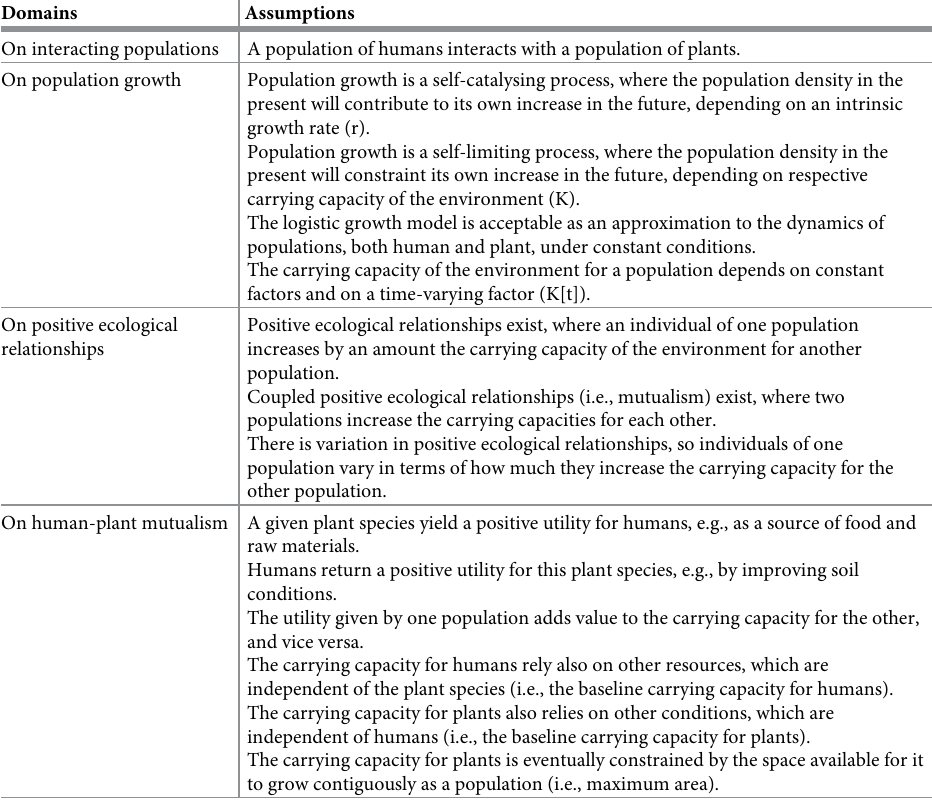
Table 4. Assumptions on ecological relationships and population